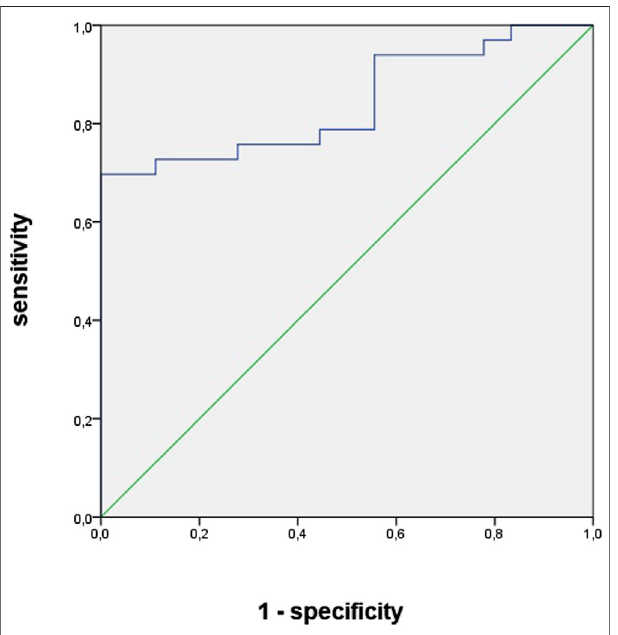
FIGURE 4 | Area under curve of TIMP-2 multiplied by IGFBP-7 and normalized by urinary creatinine between 144 and 192 h as predictors of recovery of kidney function in patients undergoing vancomycin and hospitalized in